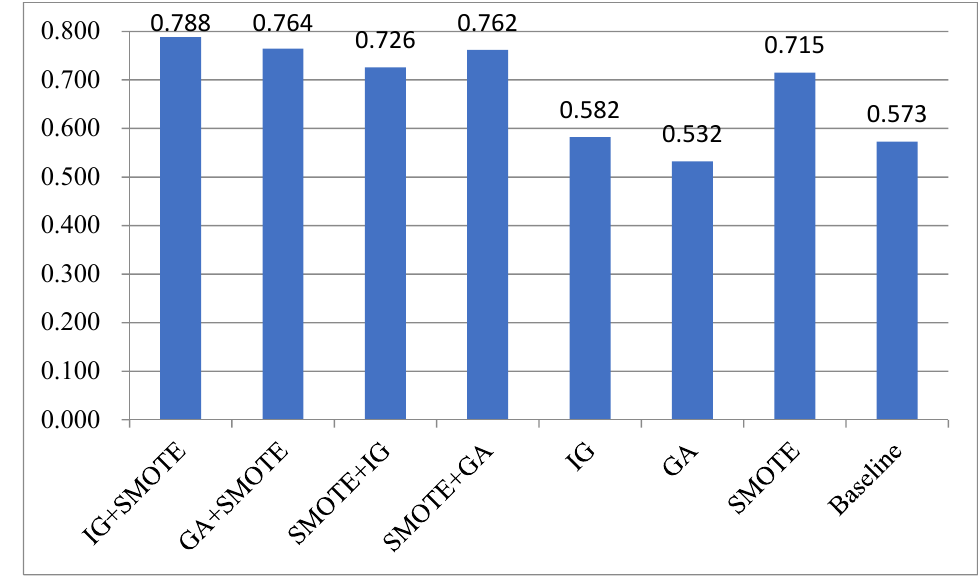
Figure 1. AUC rates of different approaches over the KDD Cup 2008 breast cancer dataset.